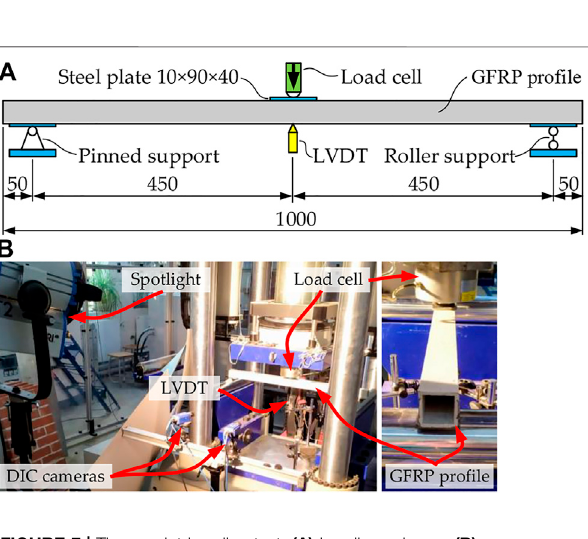
tensile strength and elastic modulus, were determined in the pultrusion direction, corresponding to the fi lament orientation. All coupons were tested using a 250 kN capacity servo-hydraulic